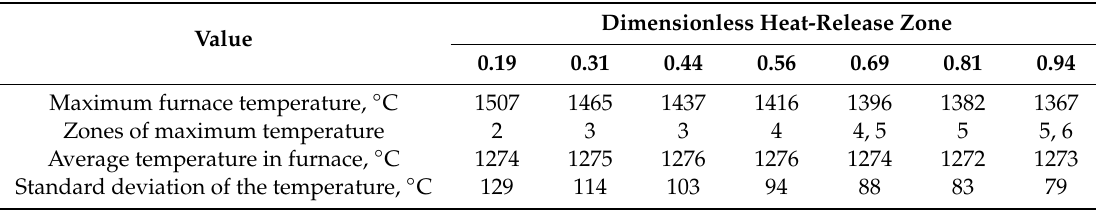
Table 2. Results of the calculation of flame and volume combustion.